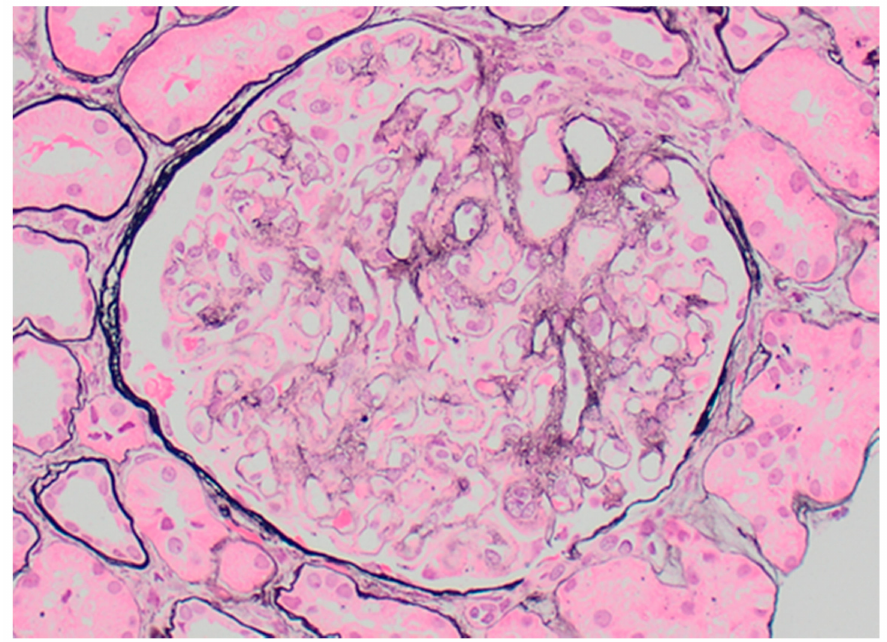
Figure 7. Proliferative glomerulonephritis with monoclonal deposits, with prominent mesangial and capillary wall eosinophilic immune deposits (Jones 200 ×